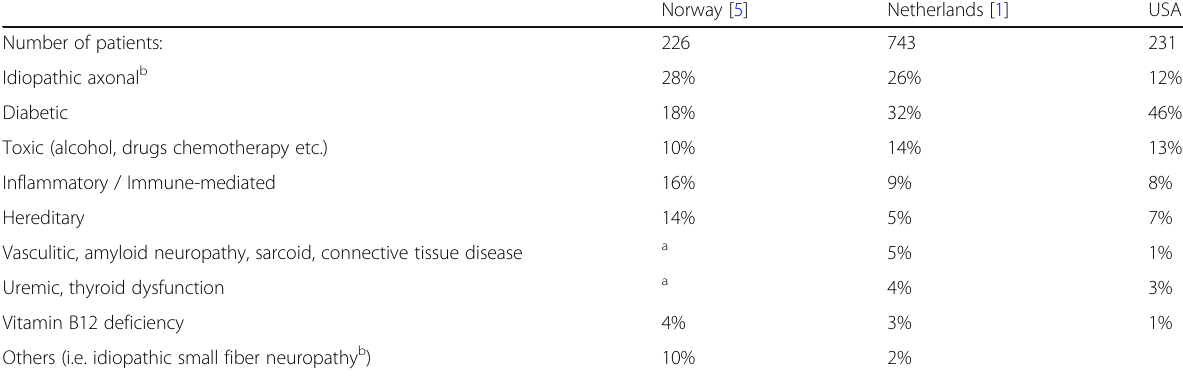
Table 1 Causes of peripheral neuropathy according to studies in Norway and the